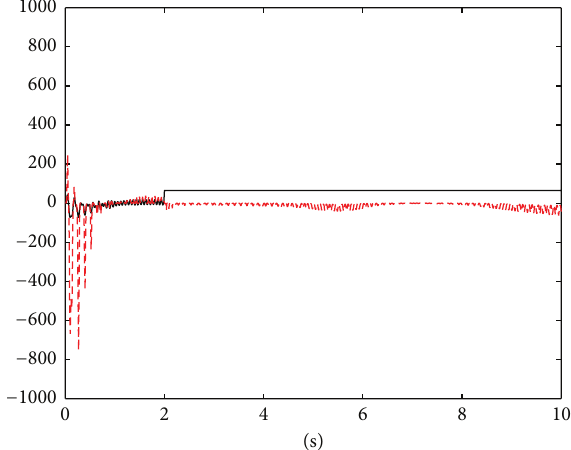
Figure 1: The curves of 𝑦 1 (solid) and 𝑦 𝑟 (dash).